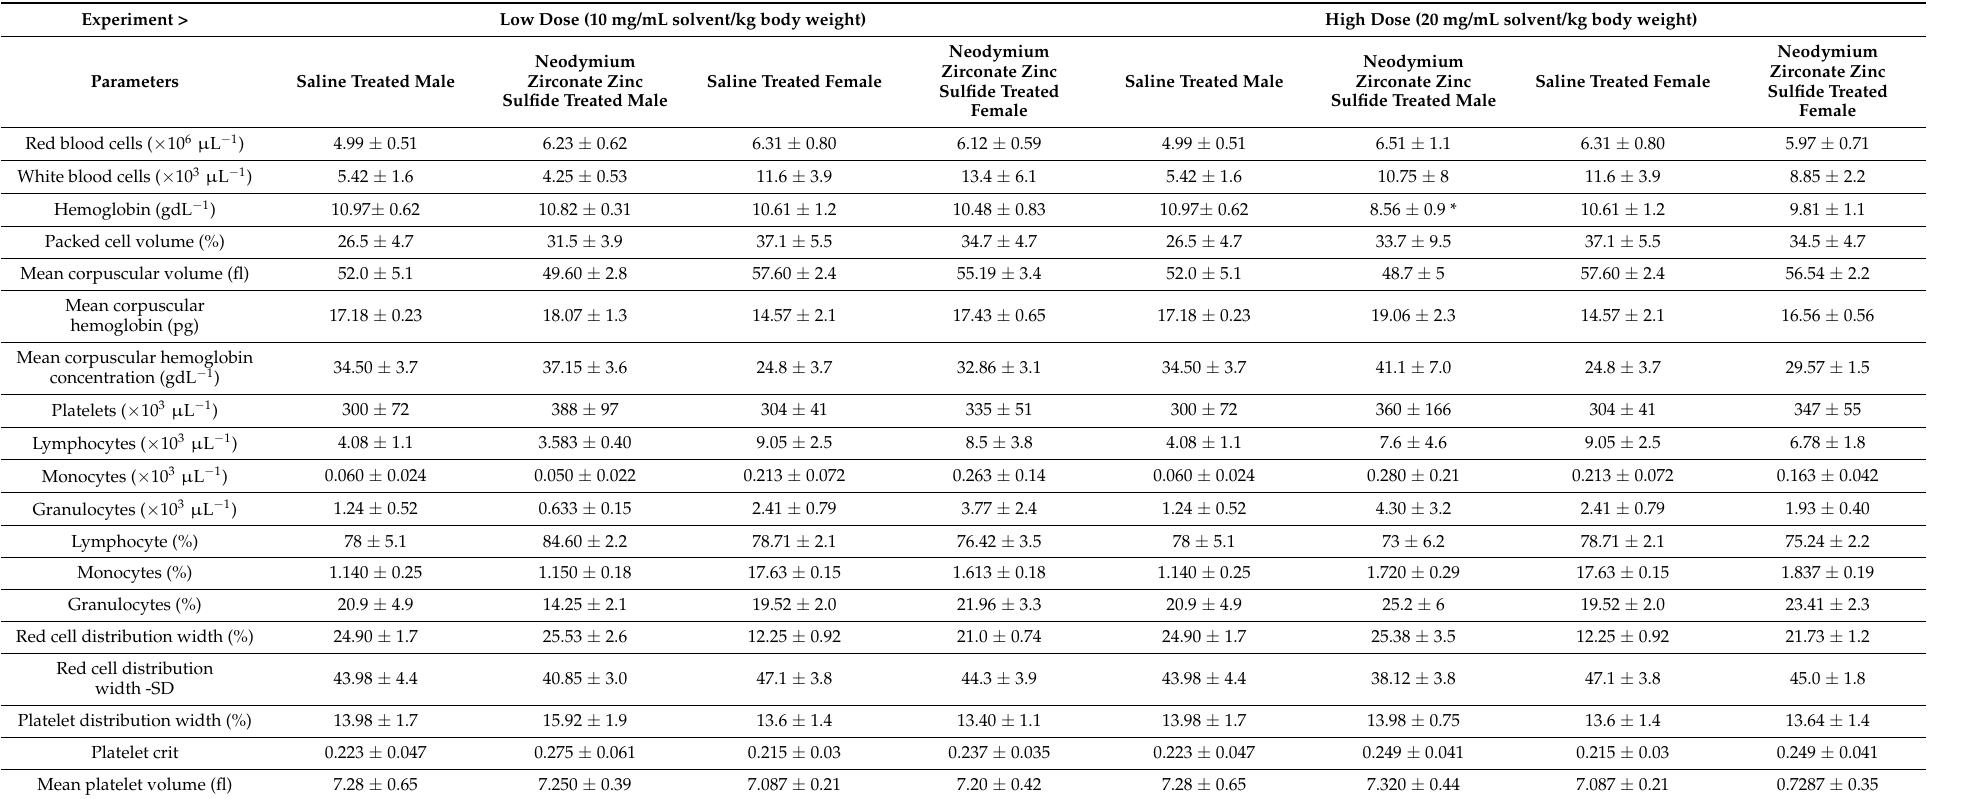
Table 1. Comparison of various studied parameters of blood count test between mice treated with Neodymium zirconate zinc sulfide nanocomposite, treated with each treatment. Data are expressed as mean ± standard error of mean. p -value represents the results for two-sample t -test calculated for each studied